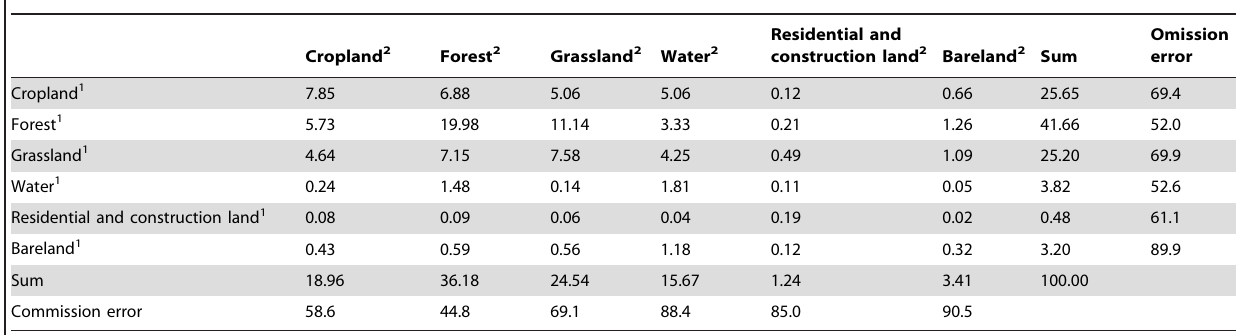
Table 4. Error matrix of the combination model (20%, 20%).